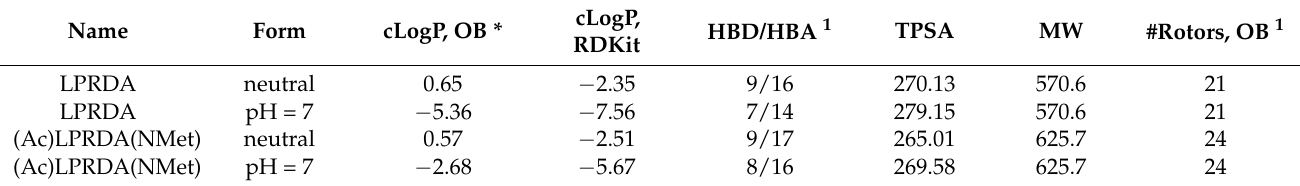
Figure 10. LPRDA in a fully charged state—both side chains as well as N- and C-termini. Table 2. Druglike properties of neutral/charged (at pH = 7) LPRDA and its N- and C-termini amide substituted analogs.